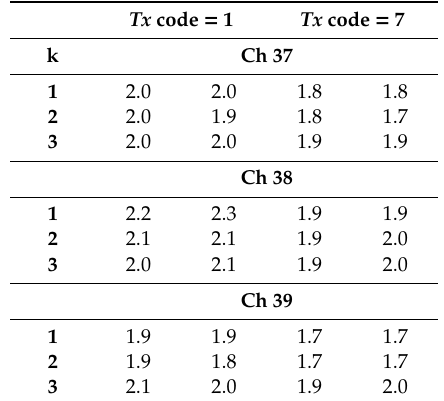
Table 24. Accuracies (in m) for Tests #9. For each value of A , the first and second data columns refer to the iBeacon and Eddystone protocol respectively. The three advertising channels are referred to as Ch 37, etc., and the number of neighbors in the WKNN algorithm, as k